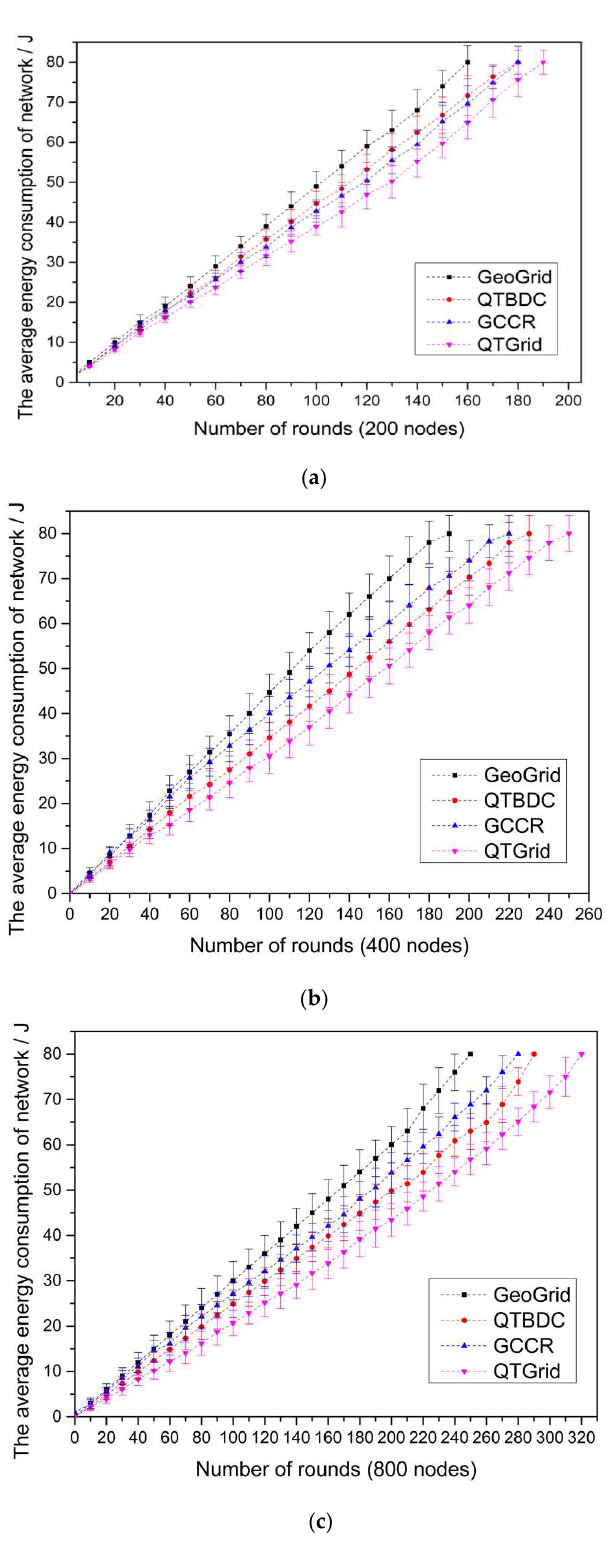
Figure 8. The comparison of the average network energy consumption. ( a ) Network with 200 nodes; ( b ) network with 400 nodes; ( c ) network with 800 nodes.